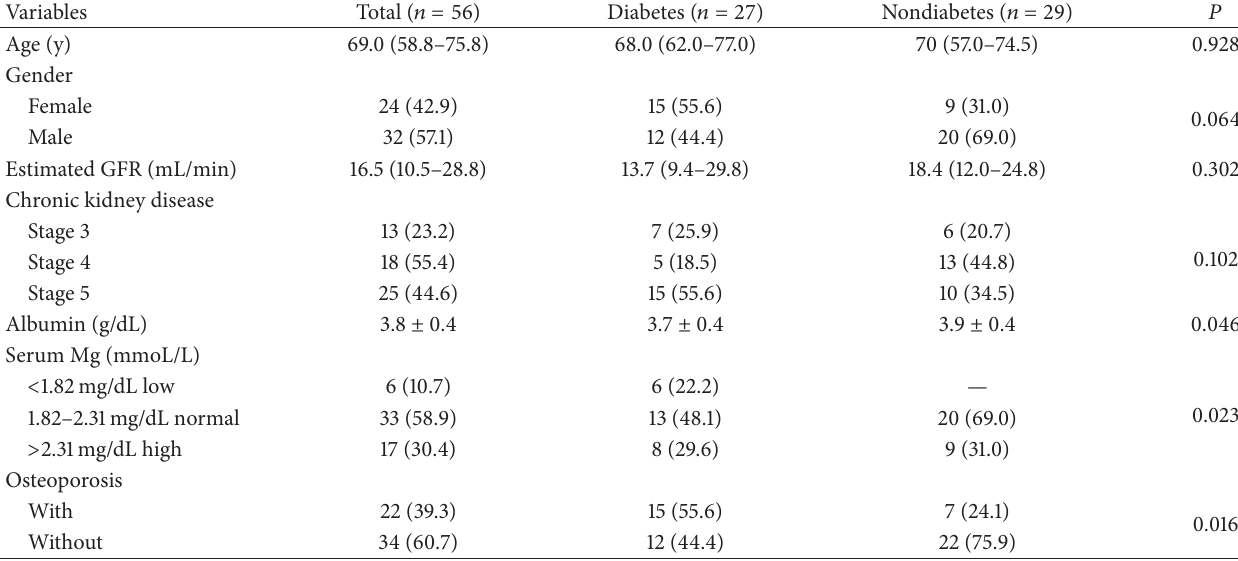
Table 1: Characteristics of the 56 nondialysis CKD patients with or without